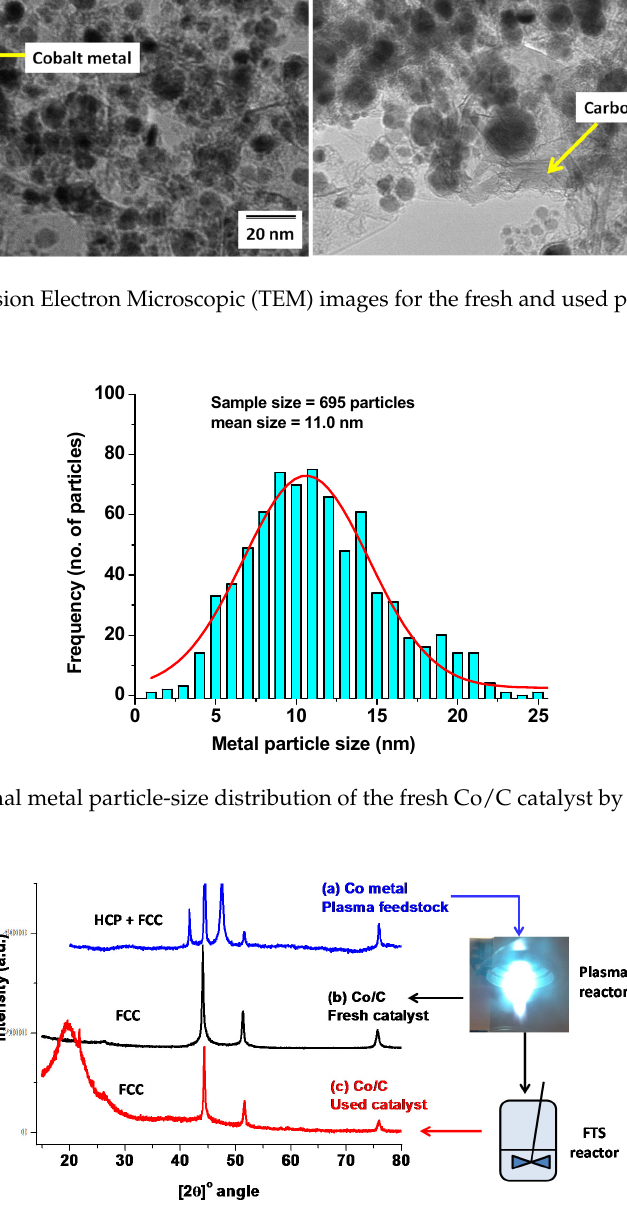
Figure 4. X ‐ ray diffraction (XRD) patterns for the ( a ) Co metal; ( b ) freshly plasma ‐ synthesized Co/C catalyst and ( c ) used sample. catalyst and ( c ) used